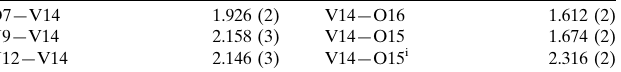
Selected bond lengths (A˚ ).